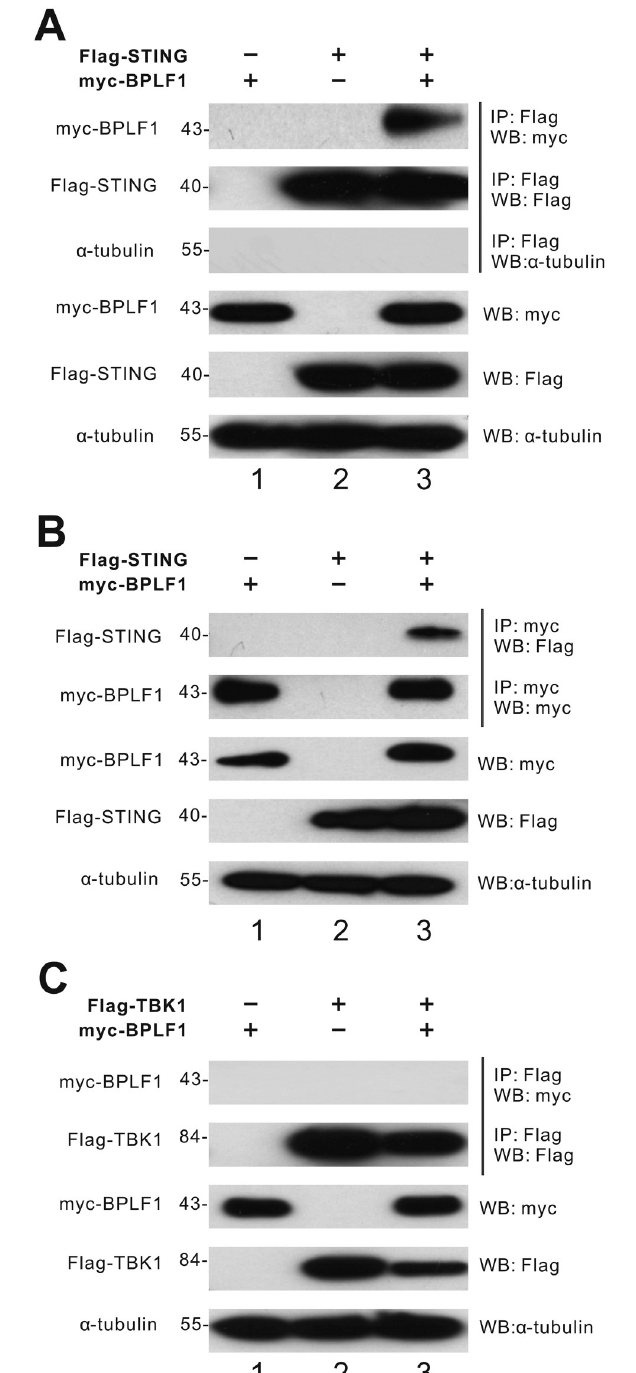
Fig 6. BPLF1 binds to STING, but not TBK1. (A, B) Co-immunoprecipitation of BPLF1 and STING. Myc-BPLF1 and Flag-STING expression plasmids were expressed in HEK293T cells. (C) No association between BPLF1 and TBK1. Myc-BPLF1 and Flag-TBK1 were expressed in HEK293T cells. Cells were harvested 24 hours after transfection for co- immunoprecipitation. The Flag-tagged STING and TBK1 proteins were pulled down by anti-Flag antibodies. The bound fraction of the immunoprecipitates (IP) and the total lysates (input) were analyzed by Western blotting (WB) with anti-Myc, anti-Flag and anti- α -tubulin antibodies.